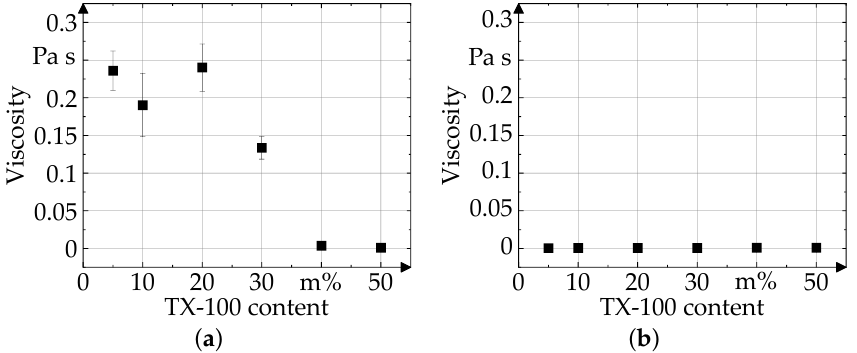
Figure 3. Viscosity as a function of TX-100 content for ( a ) an aqueous dispersion containing 10 m% graphite nanoparticles (see Table A3) and ( b ) a TX-100 solution without nanoparticles (see Table A4). The viscosity curves for both graphite dispersions (PVP and TX-100) show a similar progression. Below, a PVP content of 20 m% or a TX-100 content of 40 m%,